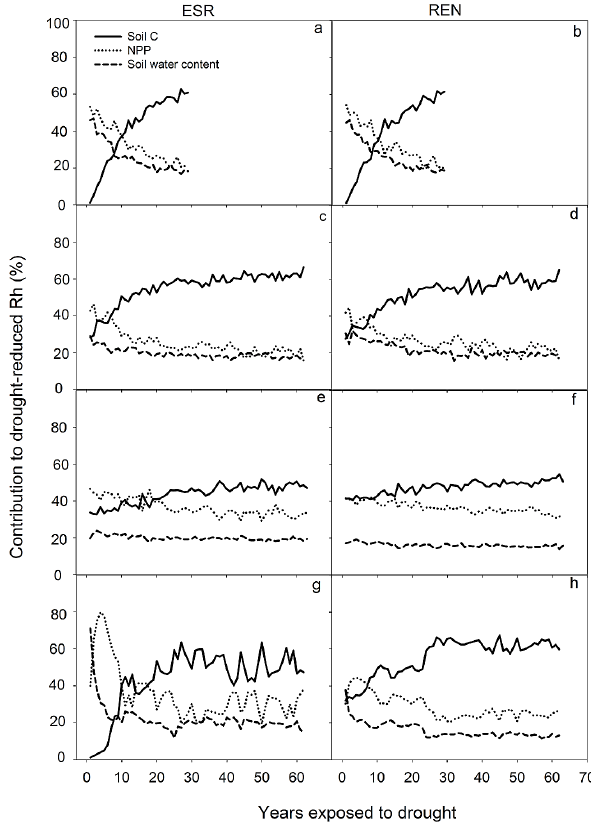
Fig. 7. Relative contributions to drought sensitivity of R h from re- ductions in soil C content, NPP and soil water content under both rainfall reduction treatments in four North American grasslands (Konza: a and b ; Hays: c and d ; Cheyenne: e and f ; Sevilleta: g and h ). Solid lines represent contribution due to reduction in soil C, dotted lines represent contribution due to reduction in NPP, and dashed lines represent contribution due to reduction in soil water